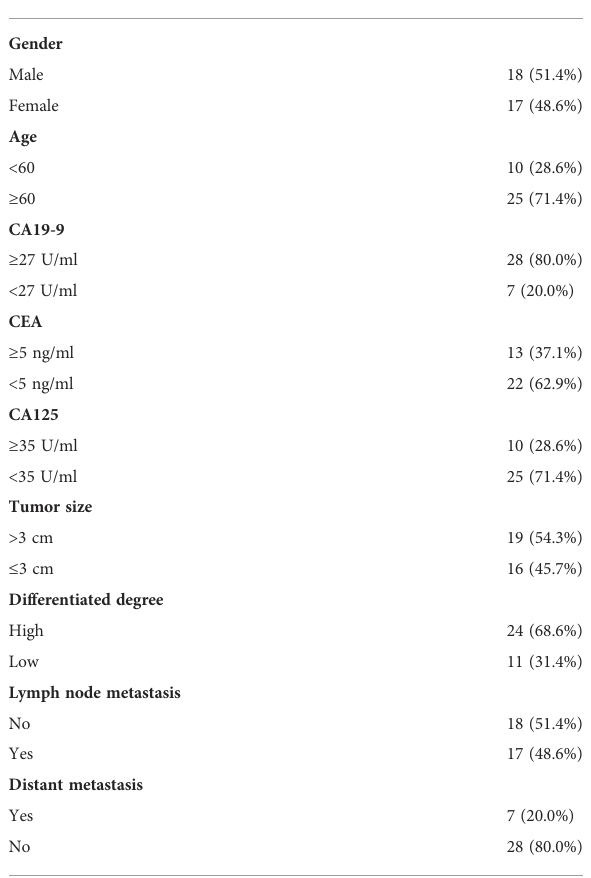
TABLE 1 Baseline characteristics of patients with pancreatic